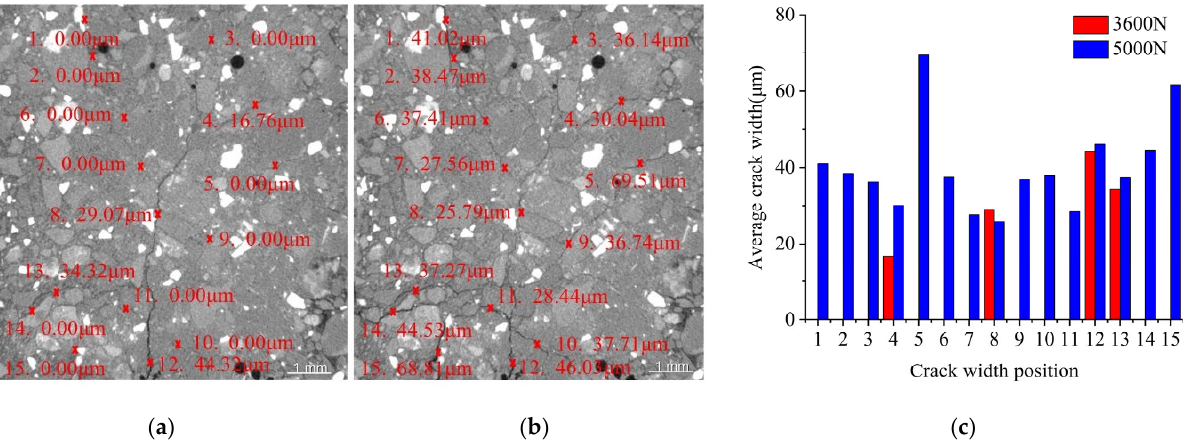
Figure 8. Analysis diagram of average crack widths under di ff erent loads: ( a ) 2D crack distribution under 3600 N; ( b ) 2D fracture distribution under 5000 N; ( c ) average crack widths under di ff erent loads.